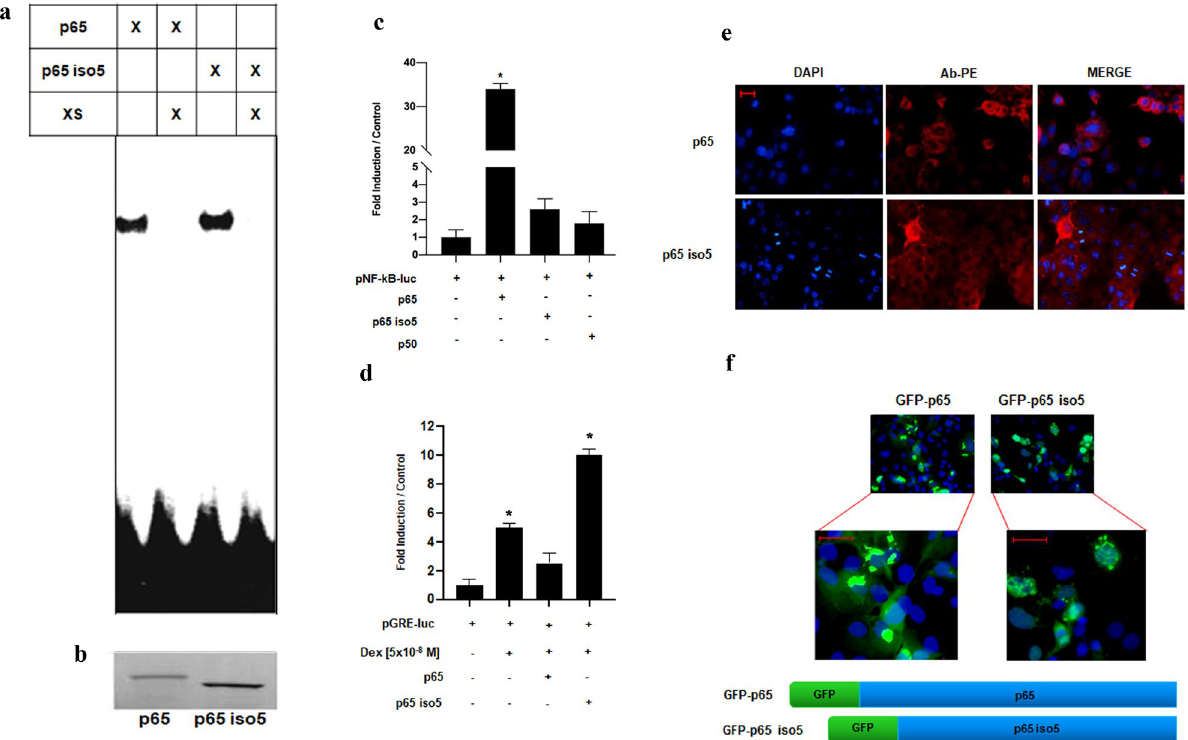
Figure 3. Biochemical and functional analysis of p65 iso5 protein and localization in the cell. ( a ) Electro mobility shift assay (EMSA) showing p65 and p65 iso5 binding activity to the radiolabelled NF-κB consensus sequence. The specific bands were suppressed by 100-fold excess of unlabelled probe. The full length image of the gel is available in the “Supplementary Information” file. ( b ) Polyacrylamide gel electrophoresis showing the in vitro transcribed and translated radiolabelled p65 and p65 iso5 proteins. The membrane has been cut prior the exposition. ( c ) Analysis of the transcriptional activity of p65 and p65 iso5. HeLa cells were transfected with a luciferase reporter driven by consensus NF-κB response elements and with the indicated expression vector. ( d ) Opposite effects of p65 iso5 and p65 on the transcriptional activity of the glucocorticoid receptor (GR) induced by dexamethasone. HeLa cells were transfected with luciferase reporter driven by specific glucocorticoid response elements (GRE) and the indicated plasmids. After transfection, GR was activated by the administration of the glucocorticoid agonist dexamethasone. ( e ) Representative of immunofluorescence of Cos-1 cells transfected with p65 and p65 iso5. In red we identified the protein using NF-κB p65 (L8F6) PE conjugate antibody that recognizes C-terminal proteins, nuclei are evidenced in blue. ( f ) Localization of p65 and p65 iso5 fused at 5 ′ with GFP (green fluorescent protein), nuclei are evidenced in blue. Data information: In ( b , c ), data are presented as mean ± SEM. *P < 0.001, in comparison to cells transfected with reporter plasmid. The full length images of EMSA and of the in vitro transcribed and translated radiolabelled p65 and p65 iso5 proteins are available in the “Supplementary Information”